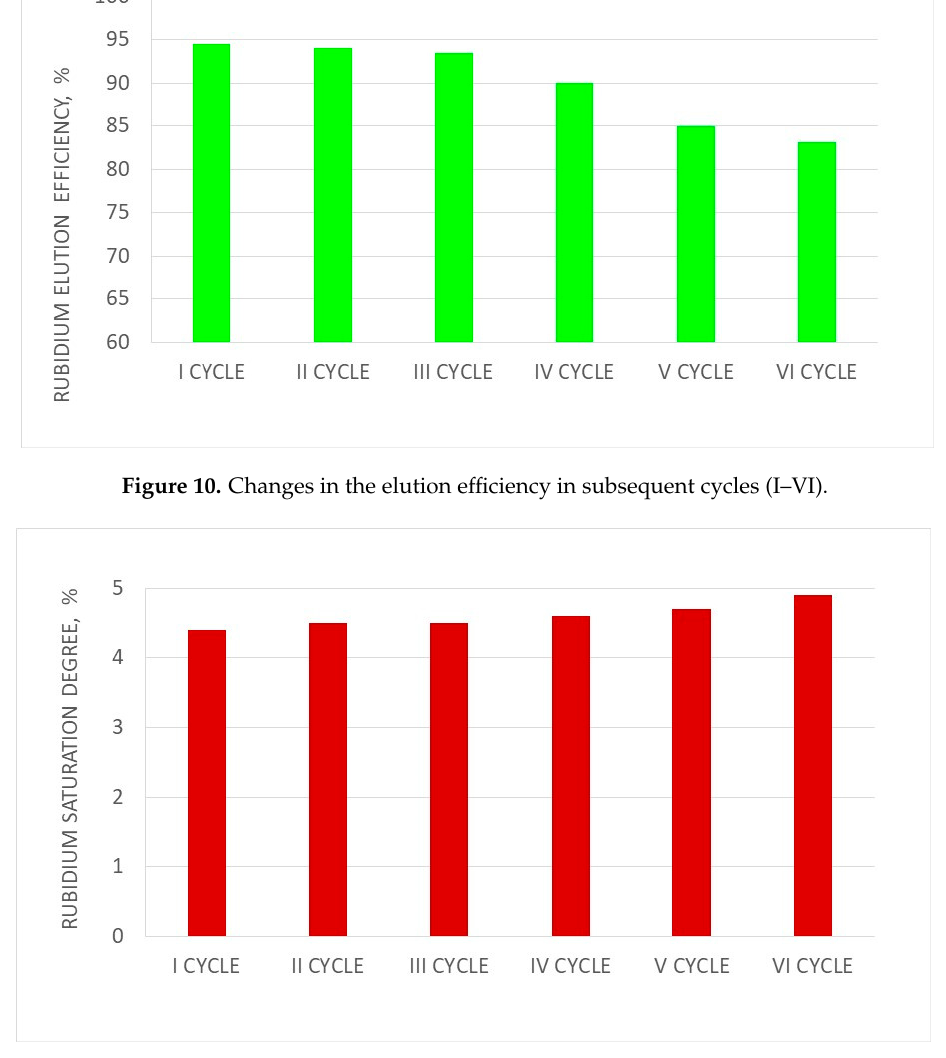
Figure 11. Changes in the saturation degree of resin by Rb in subsequent cycles (I–VI).